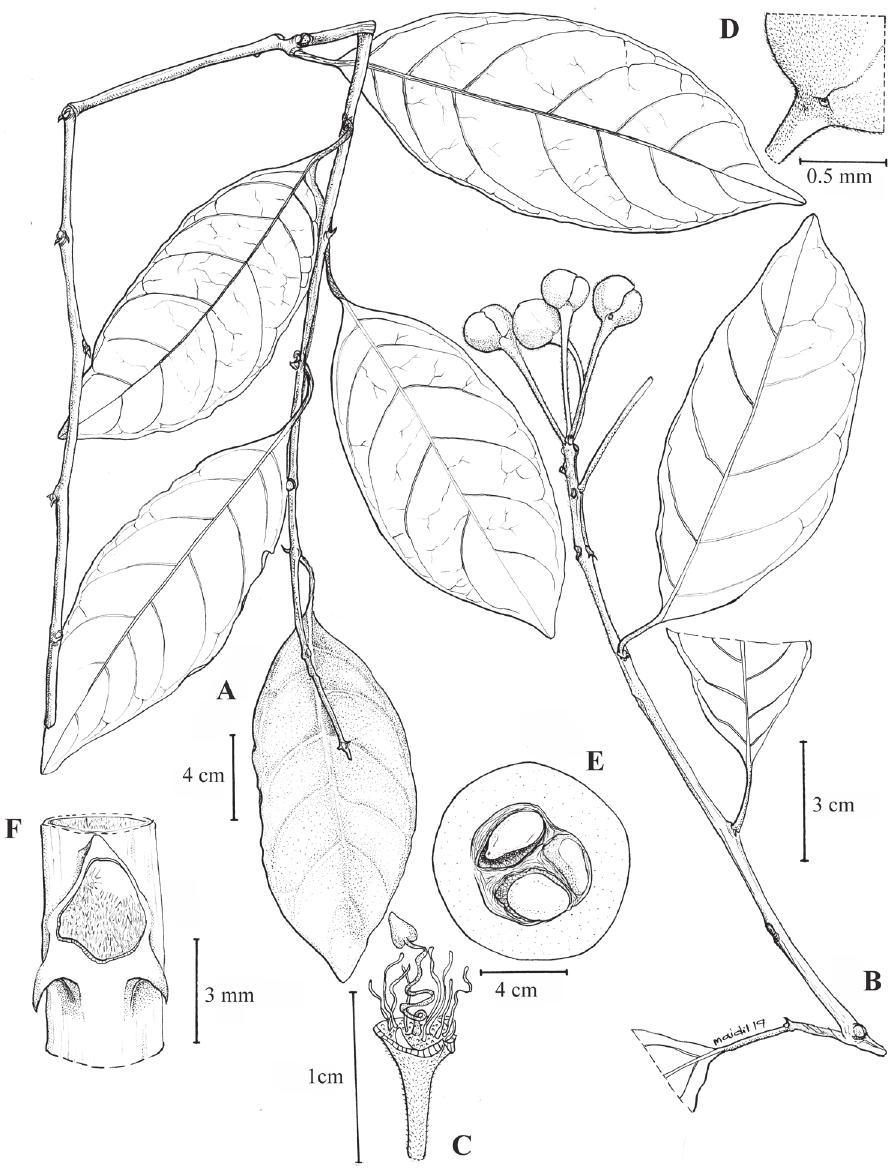
Figure 7. Capparis trinervia var. chungiana Julius, var. nov. A the leafy branch B the flowering (bud) leafy twig C flower with sepals and petals removed exhibiting the filaments and ovary on gynophore D upper pedicel and base of calyx E the fruit in cross section F stipules close-up. (Drawn by Mohamad Aidil Noordin from FRI64006 [ A, E, F ] and Mahmud Sidek s.n. [ B–D